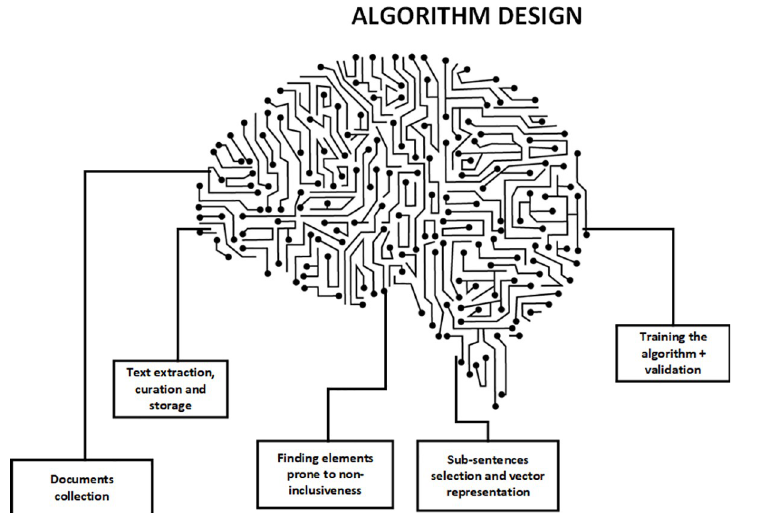
Fig 3. Conceptual definition of the algorithm